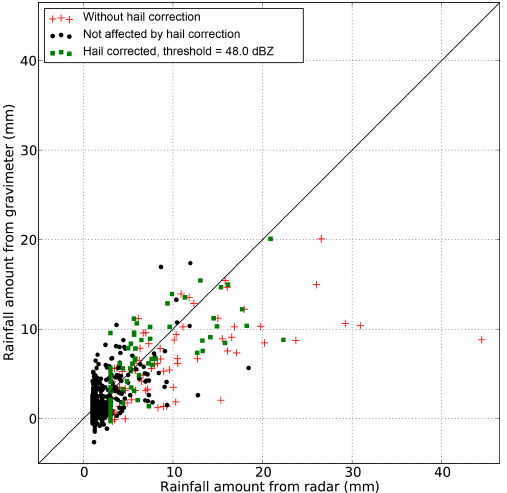
Figure 7. Rainfall amounts derived from radar and gravimeter mea- surements for 506 precipitation events with max reflectivity exceed- ing 40dBZ (black points). The MP relation is used and a hail cor- rection using a 48dBZ threshold is applied. The red crosses and the green squares correspond to radar rainfall amounts without and with hail correction, respectively. Black points correspond to the pairs that are not affected by hail correction.